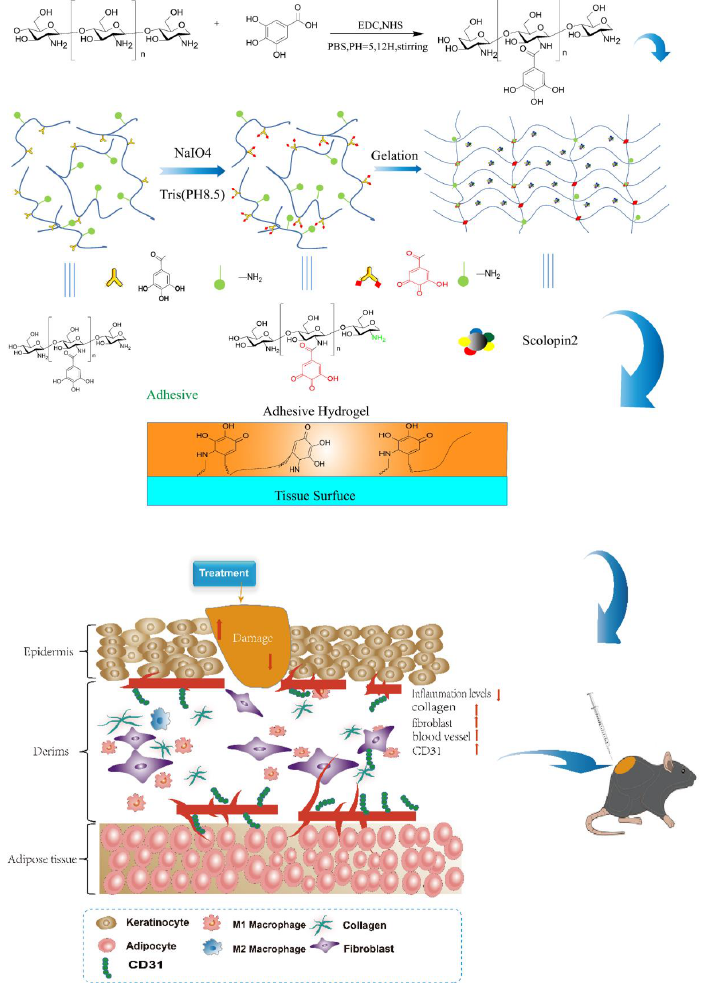
Figure 1. Schematic representation of shape-adaptive adhesive hydrogel loaded with scolopin2 for wound repair.